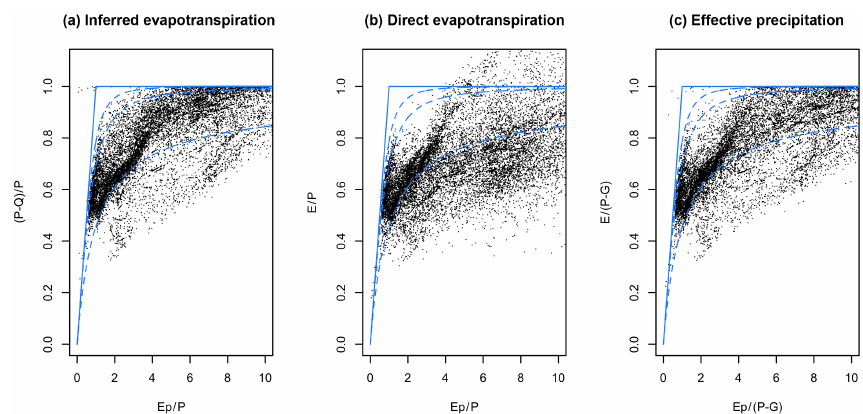
Figure 5. Budyko plots for the three approaches (a) inferred evapotranspiration, (b) direct evapotranspiration and (c) effective precipitation with points for every watershed in the domain. Dashed blue lines are Budyko curves with ω values of 1.6, 2.6 and 3.6 and the solid blue lines are the water and energy limits (refer to Fig.